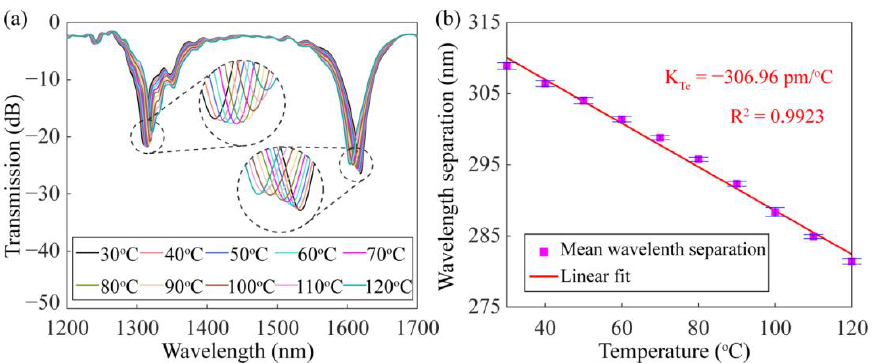
Figure 14. ( a ) Transmission spectra of the dual-resonance SMF-HLPG with different temperatures. ( b ) The dependence of mean wavelength separation on the temperature.